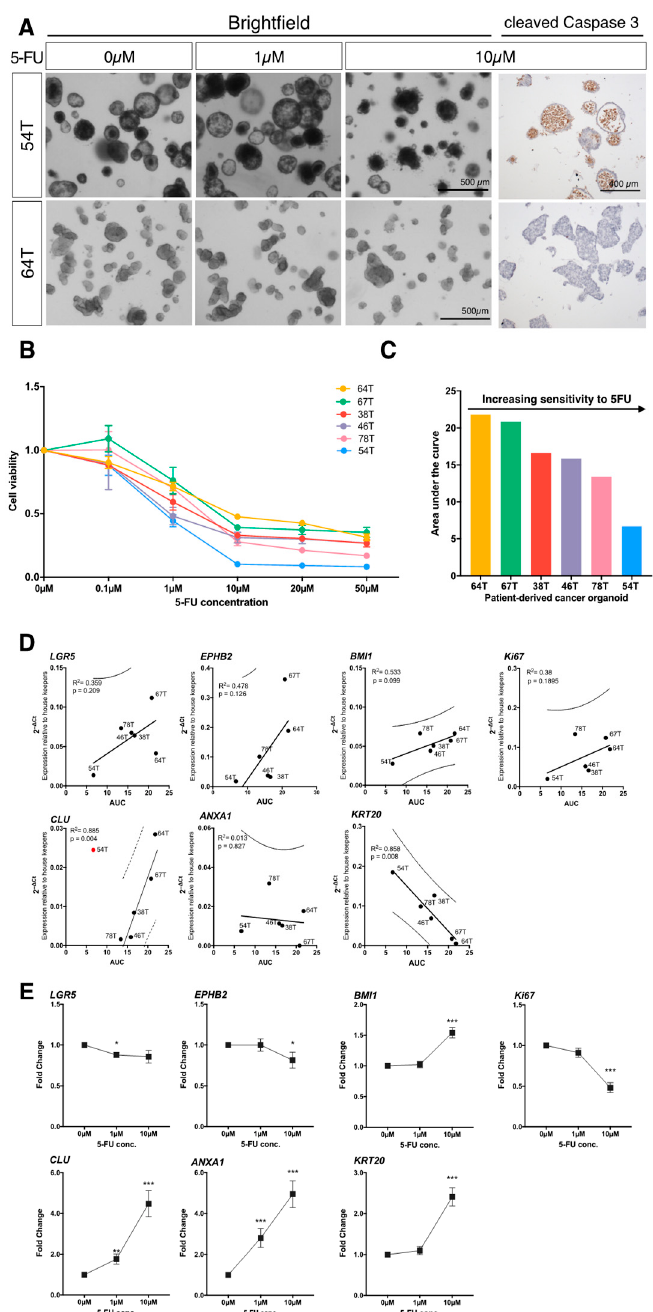
Figure 2. Elevated expression of a subset of stem cell markers correlates with resistance to chemotherapy. ( A ): Representative brightfield images of patient-derived cancer organoids (PDCOs) in response to chemotherapeutic treatment with 5-fluorouracil (5-FU) and the immunohistochemical detection of the active cleaved form of caspase 3 (apoptotic marker) in 10 µ M treated PDCOs. Scale bar, 500 µ m. ( B ): Dose-response curve of PDCOs in response to chemotherapeutic treatment with 5-FU ( n = 6, mean ± SEM). ( C ): Area under the curve (AUC) analysis of 5-FU sensitivity in six patient-derived tumoroids. ( D ): Linear regression correlation analysis between the expression of stem cell marker genes and AUC showing the best-fit line (solid line) and 95% prediction interval (dash-line). ( E ): Expression of stem cell marker genes in PDCOs in response to an increasing dose of 5-FU. Fold change is calculated by the average gene expression levels (2 − ∆ Ct ) relative to the vehicle control ( n = 6, mean ± SEM). In each graph, asterisks indicate pairs of means (compared to vehicle control) that were significantly different using Mann–Whitney test (*, p < 0.05; **, p < 0.01; ***, p < 0.001).